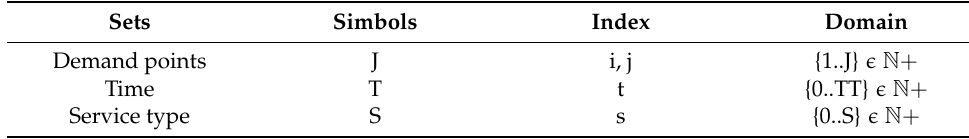
Table 2. Sets, indexes, and domains.